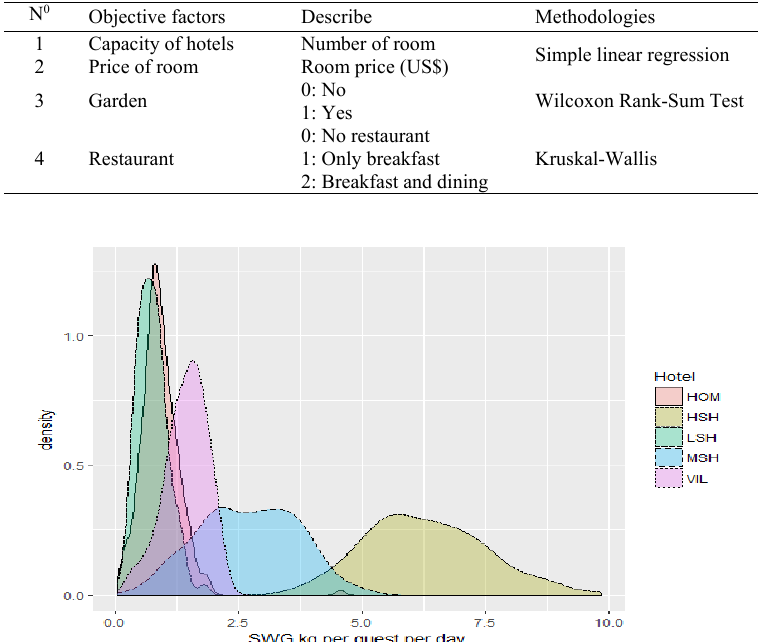
Fig. 2: Density of solid waste generation rate